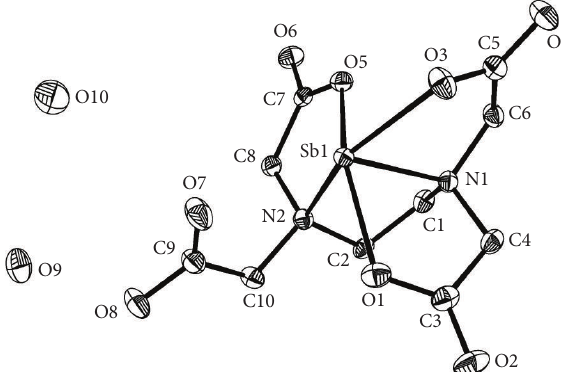
Figure 1: The molecular structure of the title